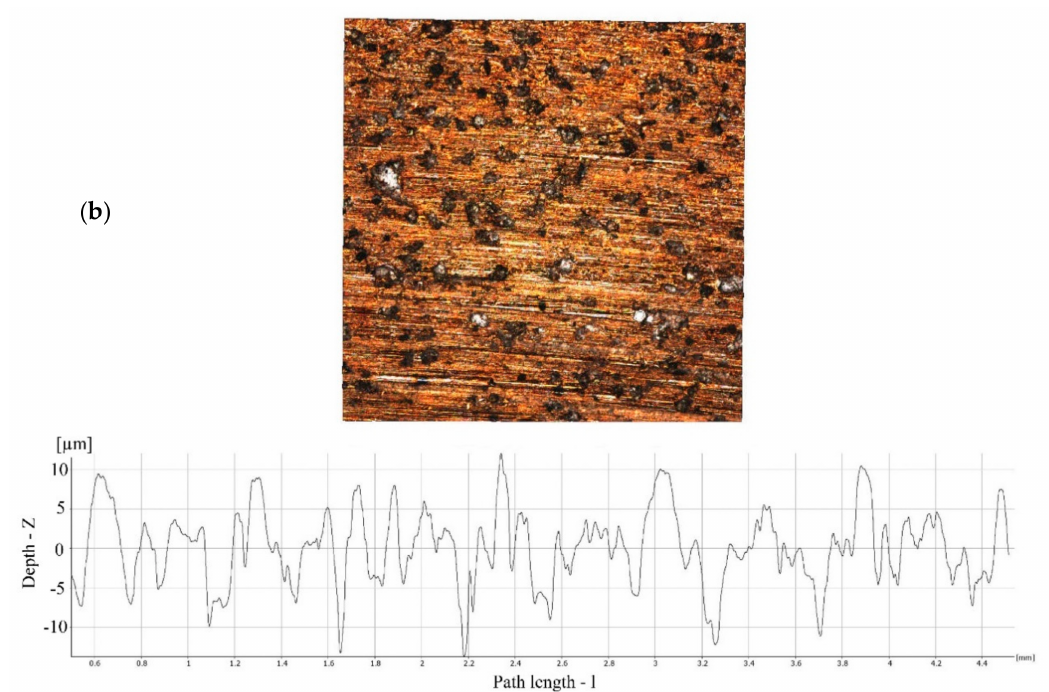
Figure 8. The representative 3D viewer pictures and 2D linear graphs showing a surface characteristic of fine-grit cutting blade ( a ) and medium-grit cutting blade ( b